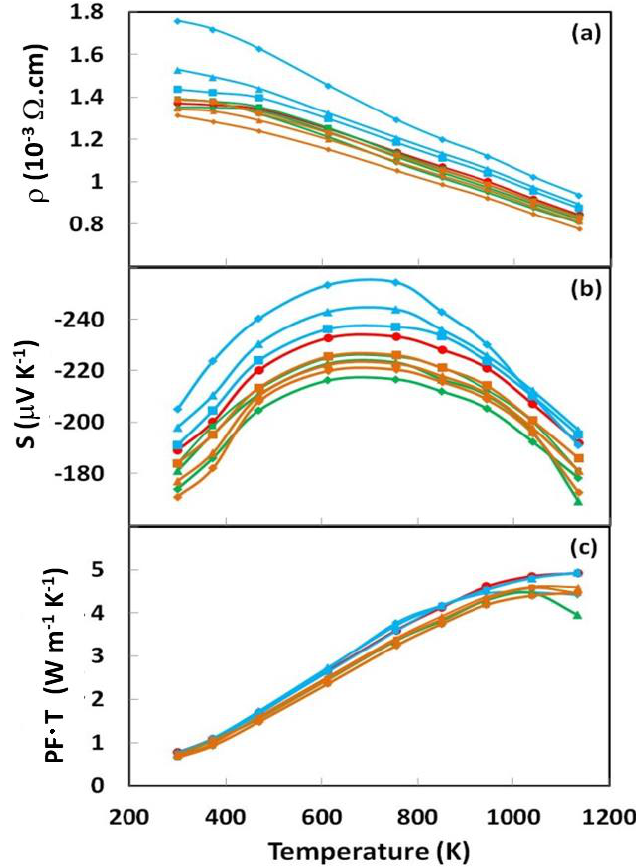
Figure 5. ( a ) Electrical resistivity, ( b ) Seebeck coefficient, and ( c ) power factor temperature product of